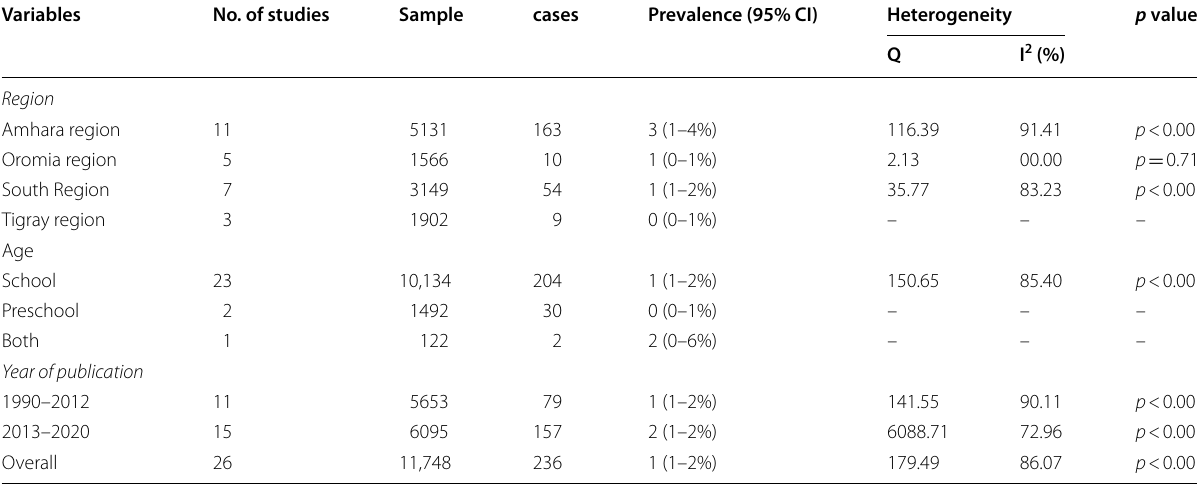
Table 7 Pooled prevalence of species specific Strongyloides stercoralis by region, age and year of publication among Ethiopian